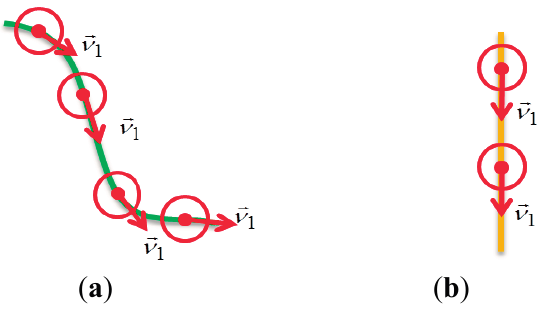
Figure 8. Principal orientation vectors along a cable ( a ) and along a pole ( b ). The arrows point to the principal direction within local